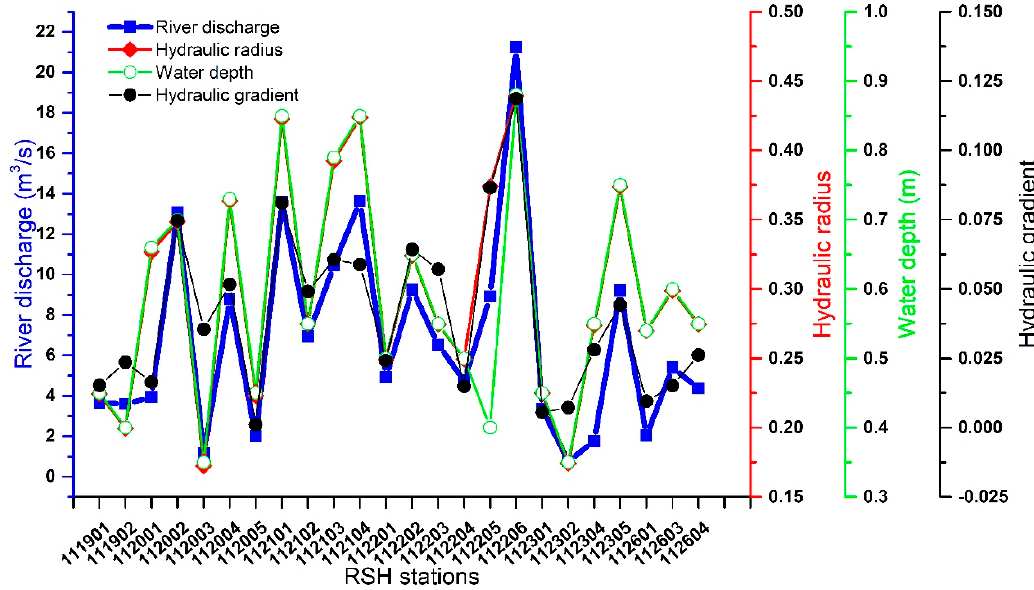
Figure 9. Sensitivity analysis of the key parameters in the formula.